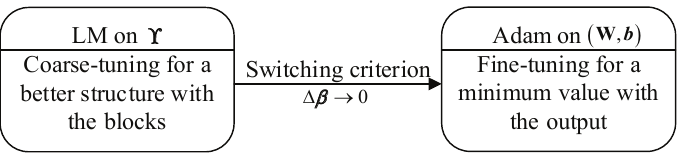
Figure 5. The principle for the proposed switch